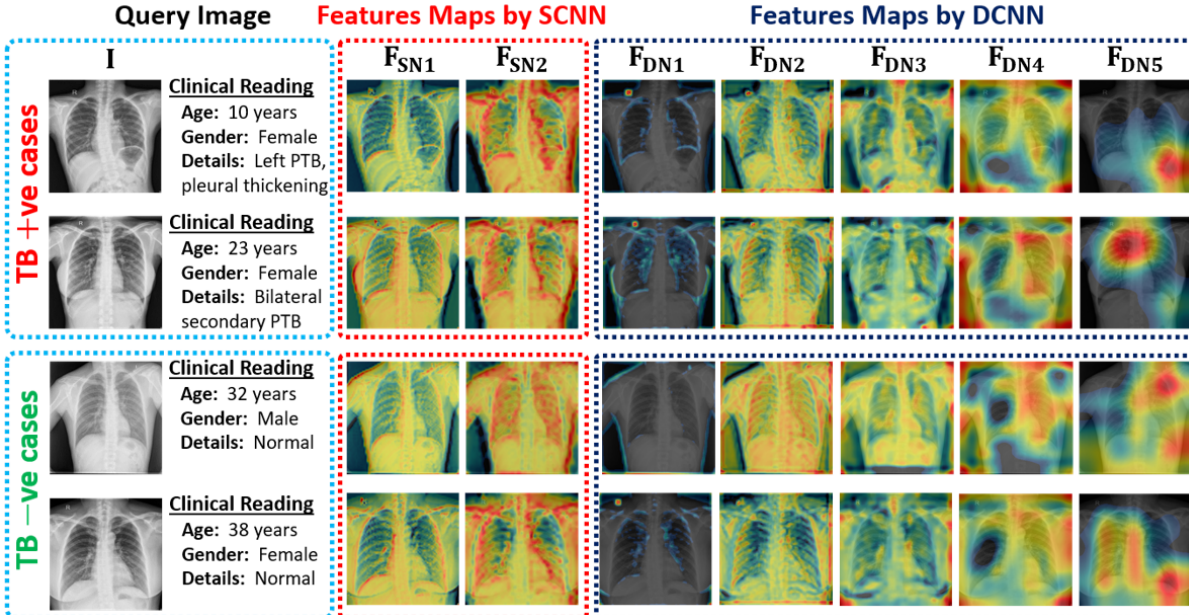
Figure 7. Extracted features maps from the different parts of the proposed ensemble-SDCNN model for both TB positive and negative cases. DCNN: deep convolutional neural network; SDCNN: shallow–deep convolutional neural network; SCNN: shallow convolutional neural network; TB: